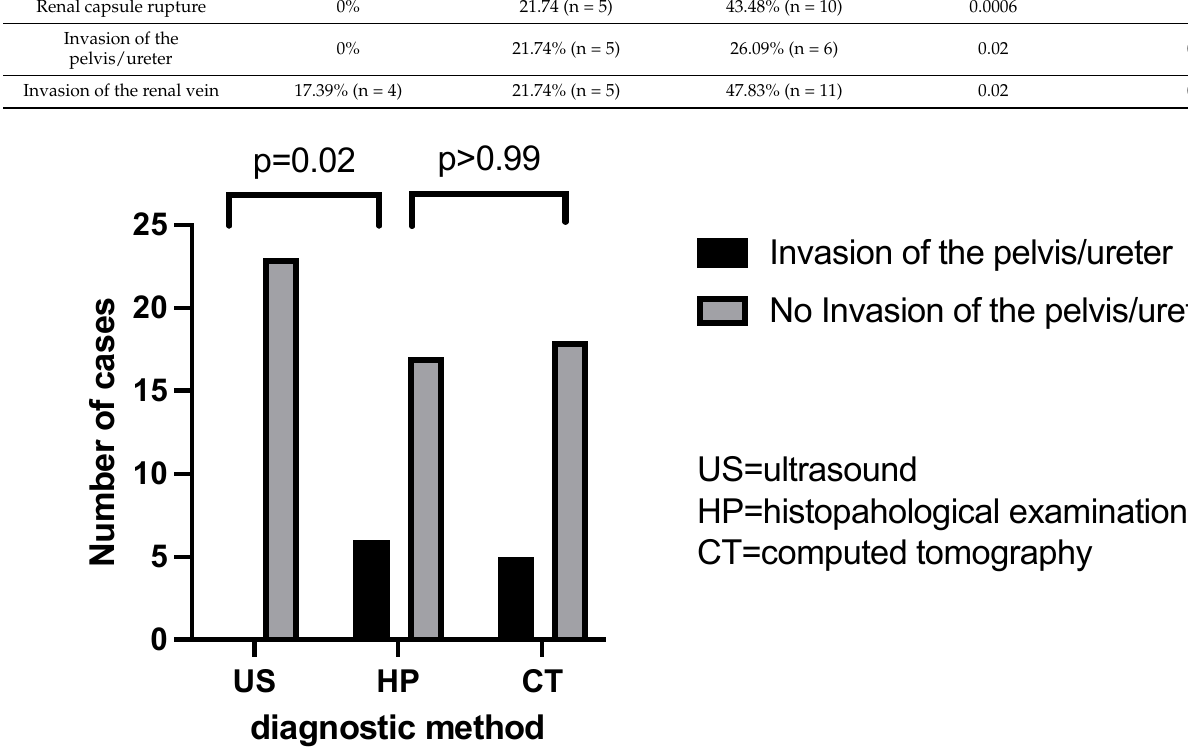
Figure 9. Renal vein invasion evaluation by US/CT comparative to histopathological examination. Table 2. Chi square analysis (US = ultrasound, TC = computed tomography, IO = intraoperatively). US Percentage and Number of Detection